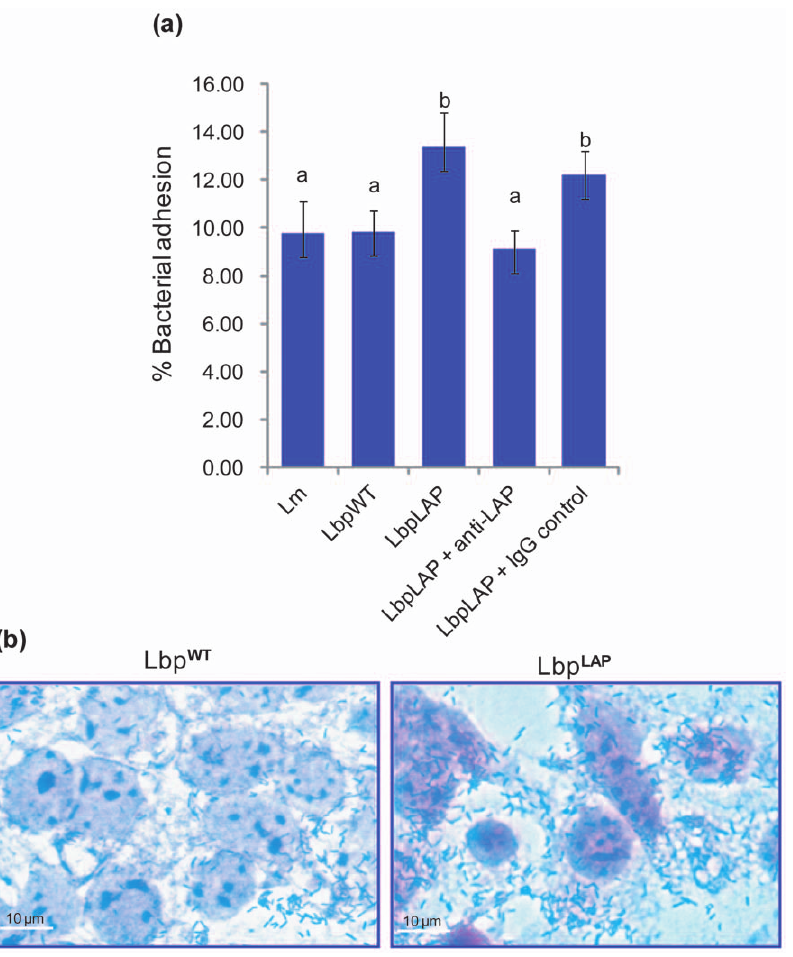
Figure 3. Adhesion characteristics of recombinant Lactobacillusparacasei (Lbp LAP ) to Caco-2 cells. (a) Adhesion of Lbp LAP was compared with wild type Lb. paracasei (Lbp WT ) and L. monocytogenes (Lm). Bacterial cells were incubated with anti-LAP MAb-H7 or immunoglobulin G controls (MAb EM-7G1) (1 m g/ml) for 30 min at room temperature, washed and added to Caco-2 cells. The number of bacterial cells that adhered to the monolayer were enumerated. Percent adhesion was calculated relative to the inoculums that were added to the Caco-2 cells for the adhesion assay. Data are average (SD) of three independent experiments performed in duplicate. Bars marked with letters (a, b) indicate significant difference at P , 0.05. (b) Representative Giemsa-stained Caco-2 cell monolayers showing visual evidence for qualitative adhesion characteristics of Lbp WT and Lbp LAP cells. Bar, 10 m m.